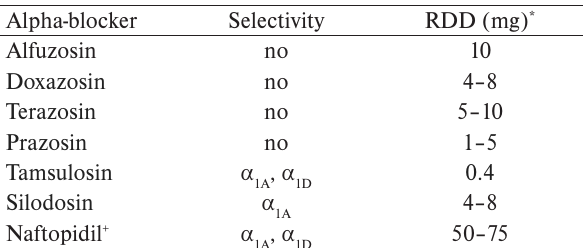
Table 2. Overview of alpha-blockers in the treatment of lower urinary tract